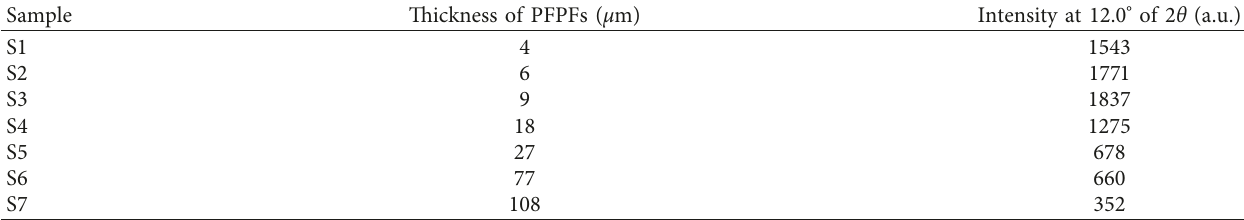
Table 1: Thickness and crystallinity intensity of PFPFs.